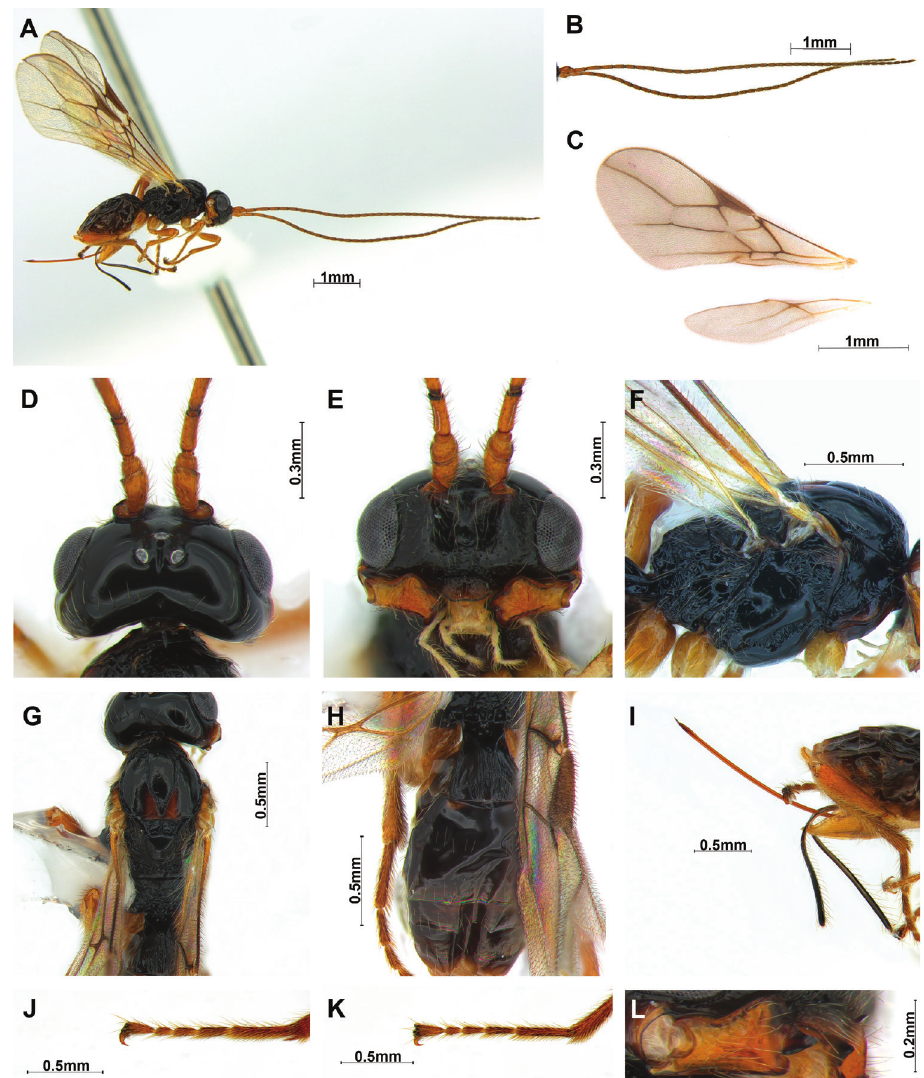
Figure 3. Phaenocarpa lobata sp. nov., ♀ A body B antennae C wings D head, dorsal E head, ante- rior F mesosoma, lateral G mesosoma, dorsal H propodeum and metasoma, dorsal I ovipositor and its sheaths, lateral J tarsus, lateral K tarsus, dorsal L mandible,